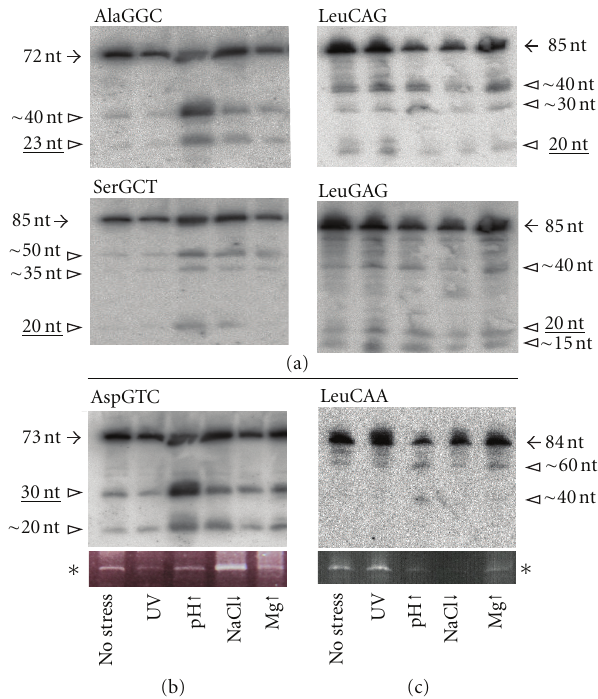
Figure 2: tRFs are present in the ribosome-associated RNome. Northern blot analyses of tRFs confirm the presence of class I (a), class II (b), and class III (c) tRFs in the ribosome-associated RNA fraction. The full-length tRNA signals are depicted by black arrows and tRFs by open arrow heads. Approximate lengths of the fragments, as deduced from RNA markers, are indicated. tRFs corresponding to the sequence reads of the cDNA library (Table 1) are underlined. RNA was isolated from unstressed H. volcanii cells (no stress), or cells grown under di ff erent permanent environmental stress conditions (ultraviolet stress (UV), high pH (pH ↑ ), 0.9 MNaCl (NaCl ↓ ), 300 mM MgSO 4 (Mg ↑ )). The 5S rRNA (asterisk) of ethidium bromide stained gels served as loading